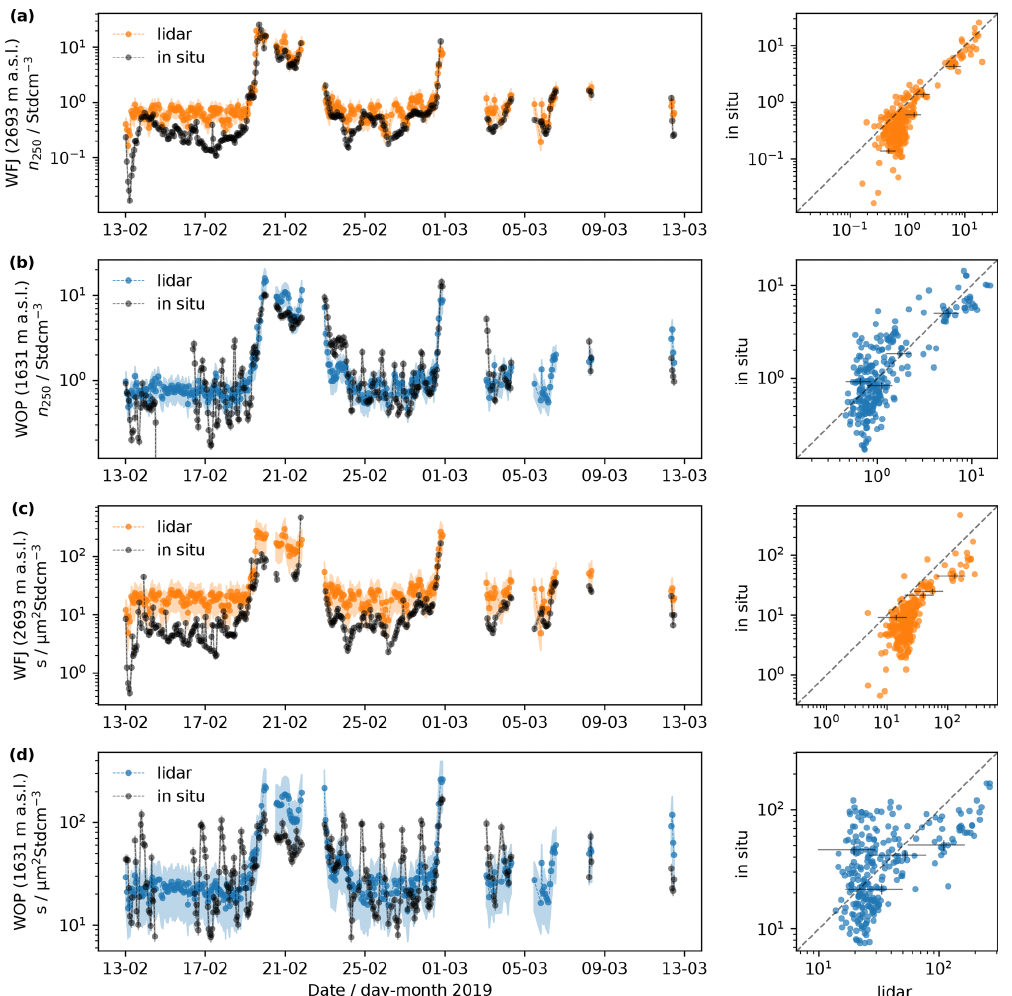
Figure 2. Comparison of aerosol properties observed in situ and with lidar. (a) Time series of aerosol number concentration with radii ≥ 250nm ( n 250 ) measured in situ (black) and with lidar (orange) at WFJ. (b) Same as (a) but measured at WOP (lidar data in blue). (c) Time series of surface area concentration ( s ) measured in situ (black) and with lidar (orange) at WFJ. (d) Same as (c) but measured at WOP (lidar data in blue). Right of each time series panel, a scatter plot compares the in situ to the lidar observations of the data presented on the left. Uncertainties are indicated by the shading for the time series and at representative data points of the scatter plots in black. Note the lidar retrieval height at WOP was 2052ma . s . l . (see Fig.